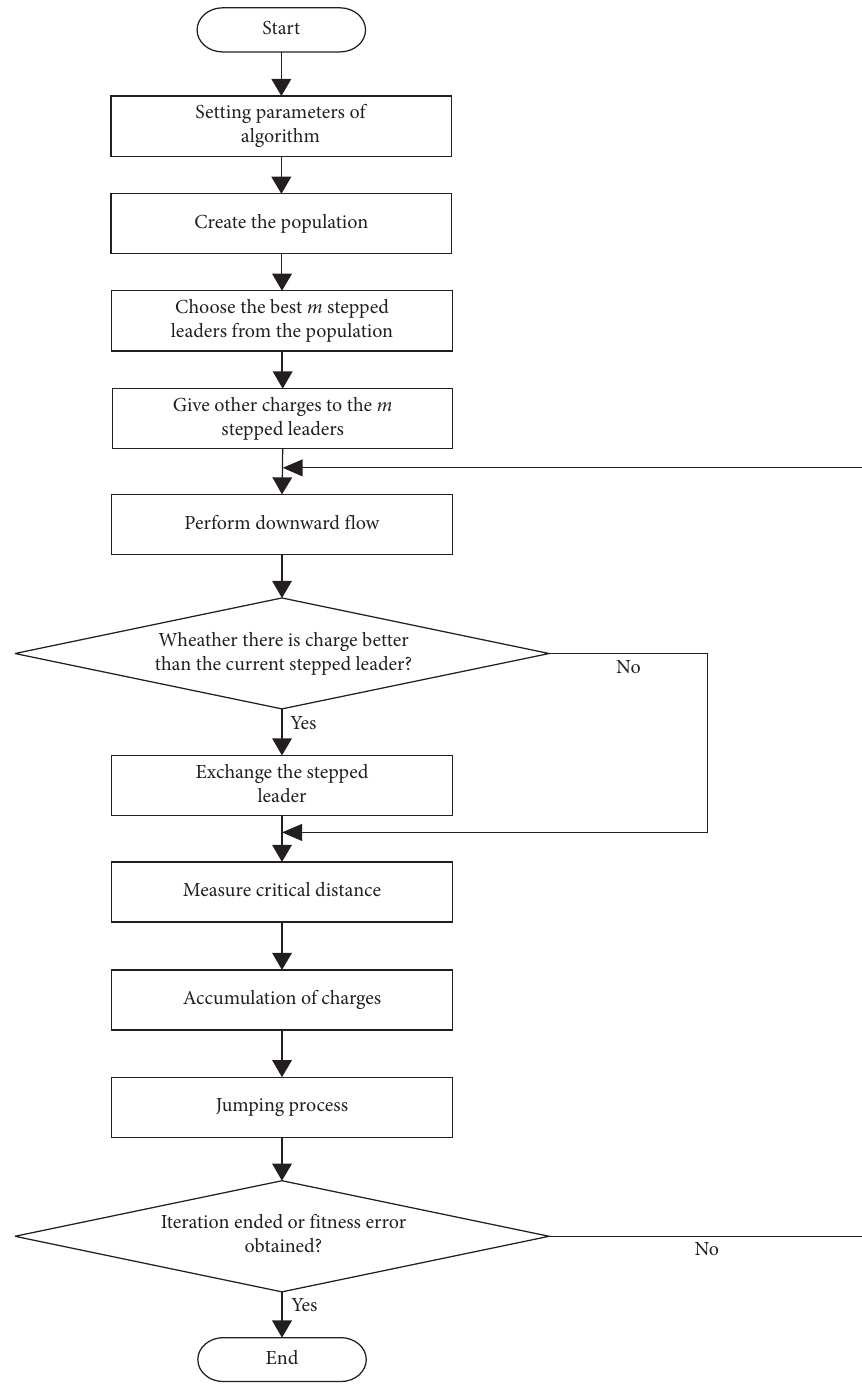
Figure 2: Flowchart of the lightning flash